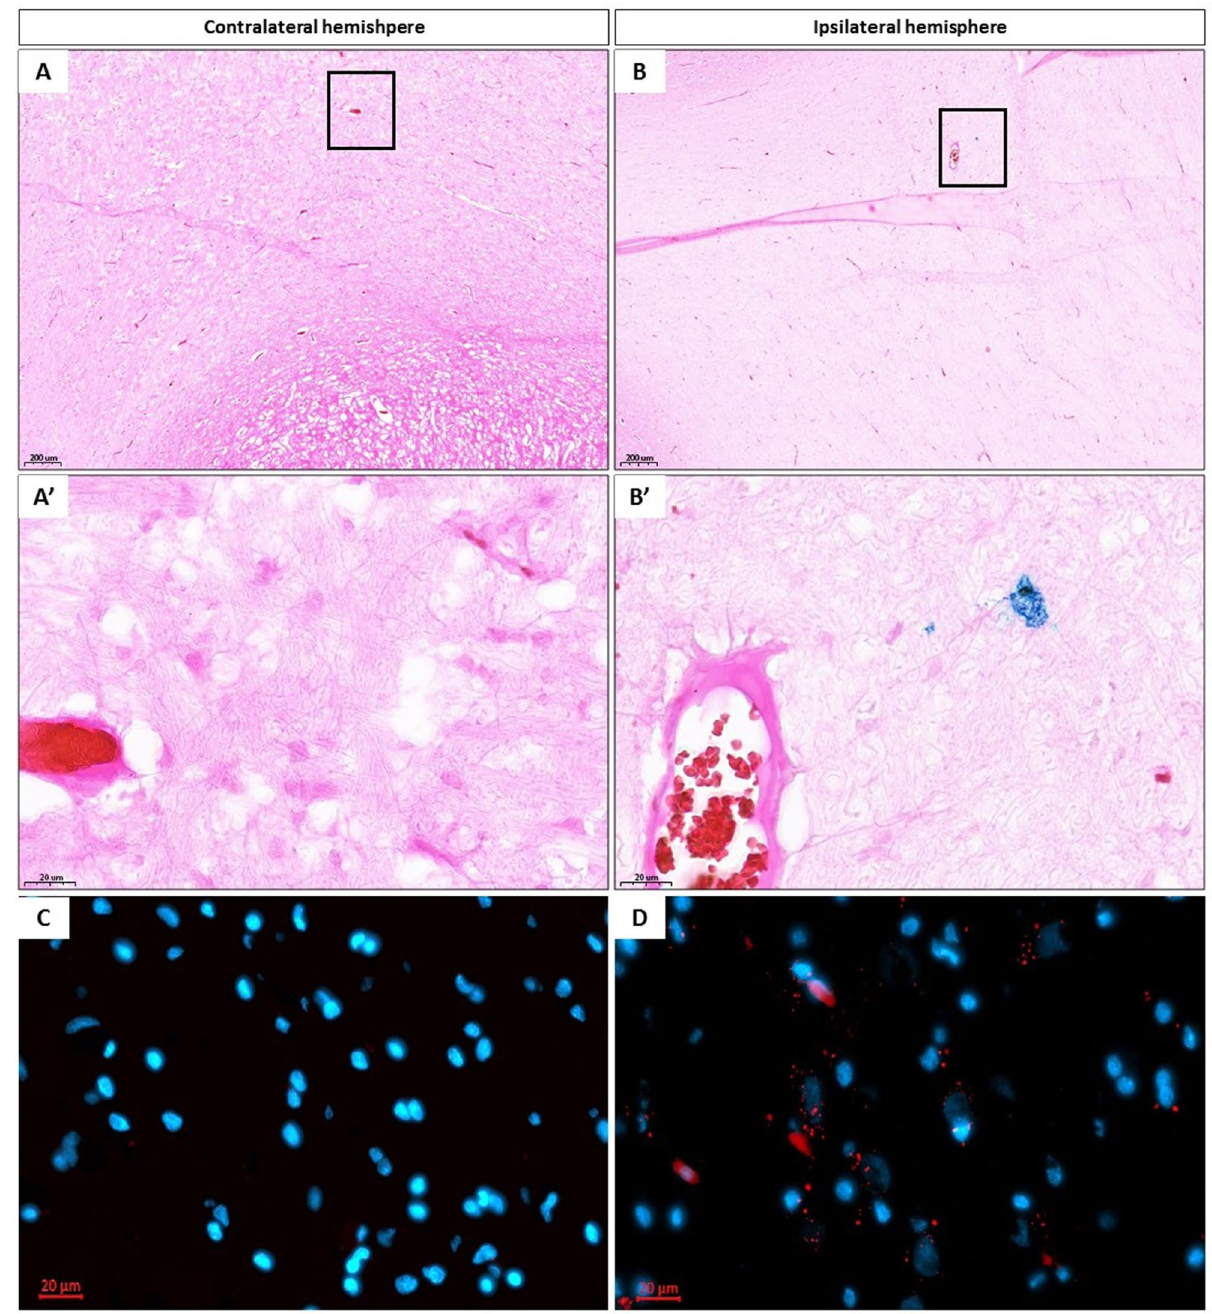
Figure 3. Histological evaluation. Prussian blue staining of brain of pigs after SPION pMSCs transplantation in contralateral [( A ) ×5 magnification, ( A ′ ) ×40 magnification] and ipsilateral hemisphere [( B ) ×5, ( B ′ ) ×40 magnification]. DAPI staining of brain of pigs after SPION pMSC transplantation in collateral [( C ) ×40 magnification] and ipsilateral hemisphere [( D ) ×40 magnification]. Red spots indicate iron oxide nanoparticles present in